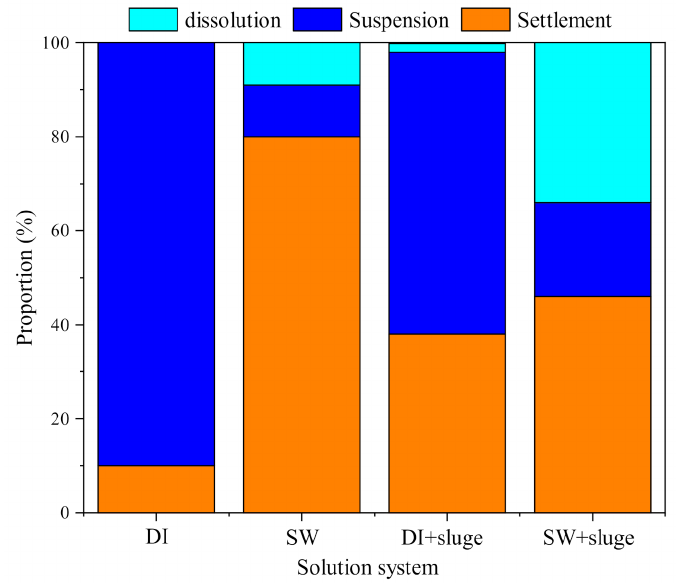
Figure 9. The mass balance of DI and SW − diluted cit − AgNPs (50 × dilution, 1.7 × 10 10 particles ml − 1 , 1.68 mg L − 1 ) with and without sludge after 220 min, such as proportions of settlement, dissolution, and suspension. Notes: pH and IS in SW was 8.7 and 100 mM, respectively. HA in sludge was 42 mg L − 1